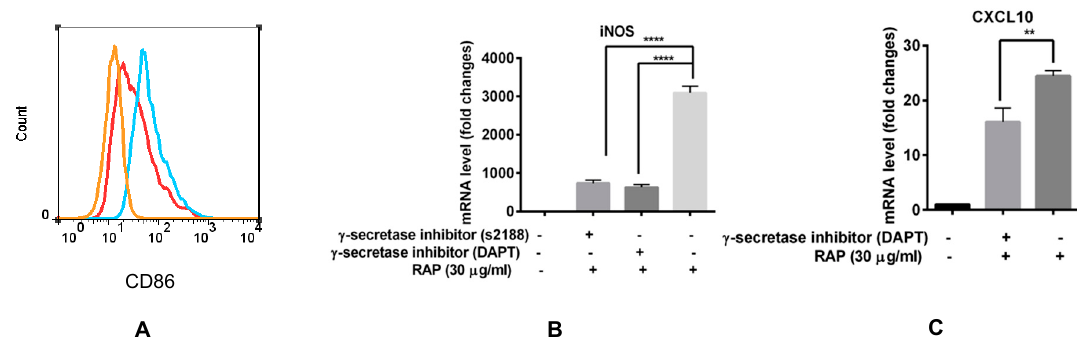
Figure 7. Blocking of Notch signaling pathway by γ -secretase inhibitor decreased M1 marker expression in the presence of RAP. ( A ) The CD86 expression was analyzed by FCM. The orange line represents the control cells. The blue line represents the RAW264.7 cells that were treated with 100 µ g / mL of RAP. The red line represents the RAW264.7 cells that were pre-treated with s2188 (80 µ M) for 1 h, and then treated with 100 µ g / mL of RAP. ( B ) RAW264.7 cells were pre-incubated with s2188 (80 µ M) and DAPT (80 µ M) for 1 h, and then treated with 30 µ g / mL of RAP. ( C ) RAW264.7 cells were pre-incubated with DAPT (80 µ M) for 1 h, and then treated with 30 µ g / mL of RAP. RNA expression of iNOS and CXCL10 were tested by qRT-PCR. A significant di ff erence of each gene expression in each group was observed by one-way ANOVA test, **** p < 0.0001, ** p < 0.01.